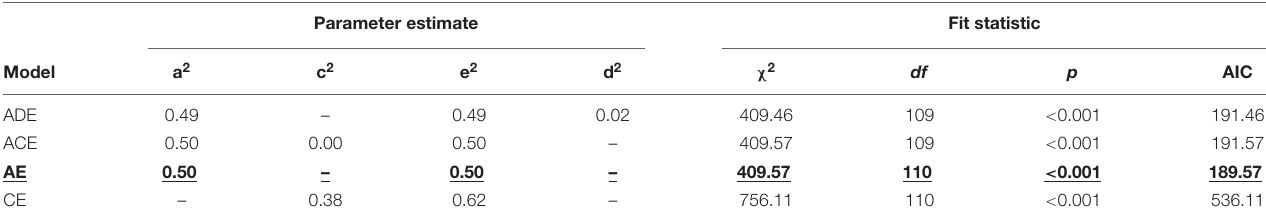
TABLE 1 | Standardized parameter estimates and fit statistics – inclusion of all data.